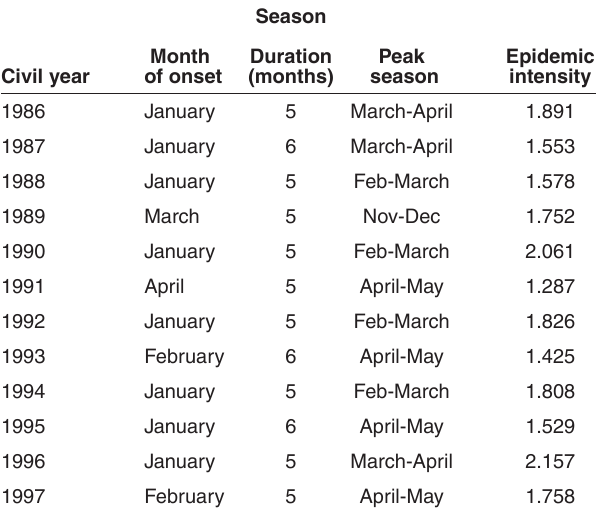
TABLE 1 Diarrhea-related hospitalizations (all diagnoses) among children younger than five years of age in Quebec,